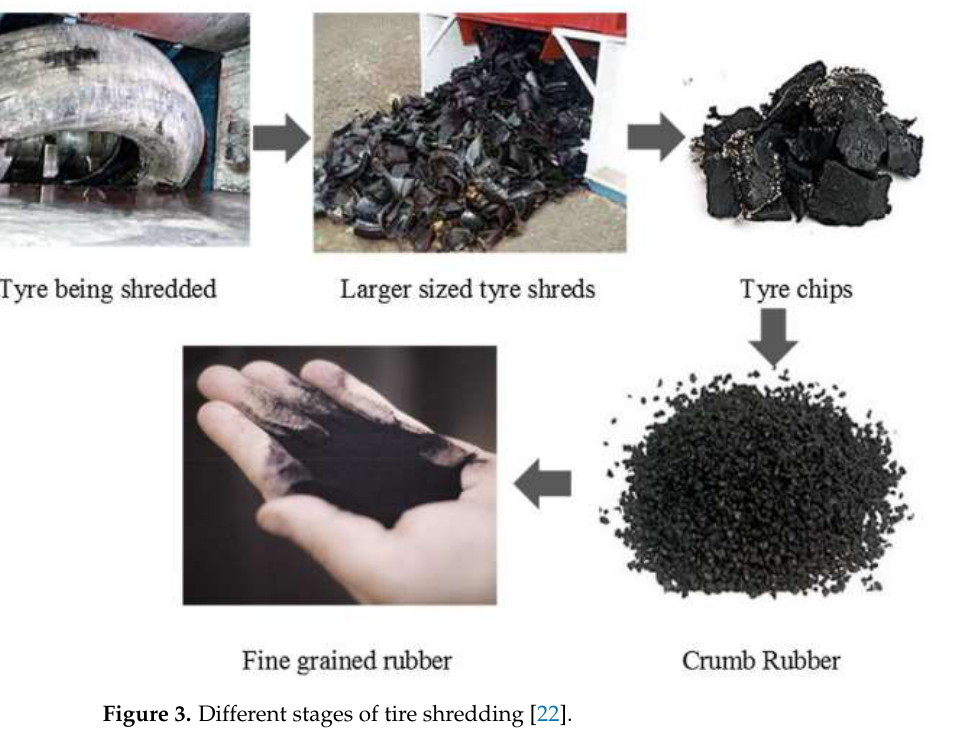
Figure 3. Different stages of tire shredding [22].